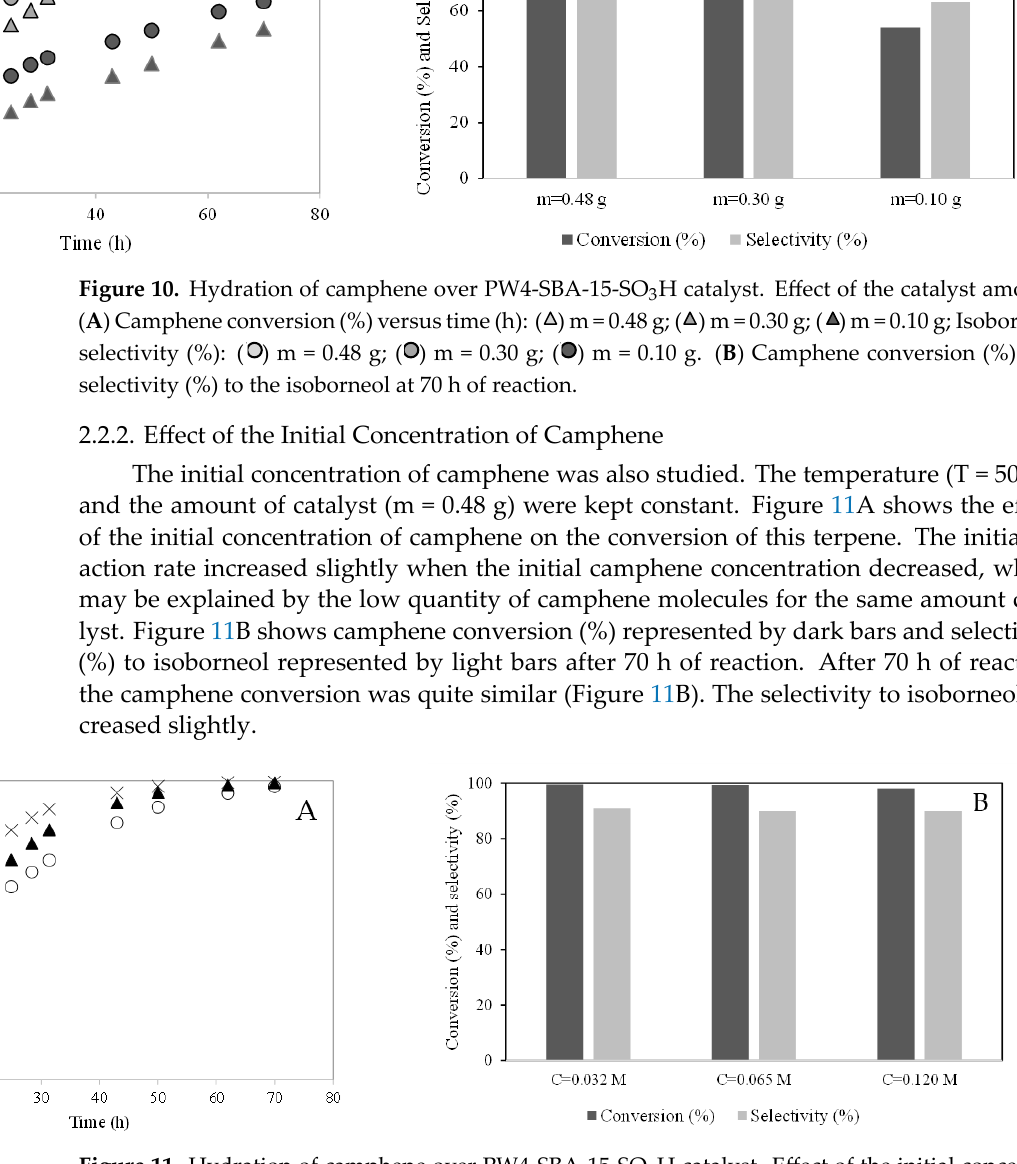
Figure 11. Hydration of camphene over PW4‑SBA‑15‑SO 3 H catalyst. Effect of the initial concentra‑ tion of camphene. ( A ) conversion (%) versus time (h): ( × ) C = 0.032 mol.L ; ( ▲ ) C = 0.065 mol.L ; ( # ) C = 0.12 mol.L . ( B ) Camphene conversion (%) and selectivity (%) to the isoborneol at 70 h of